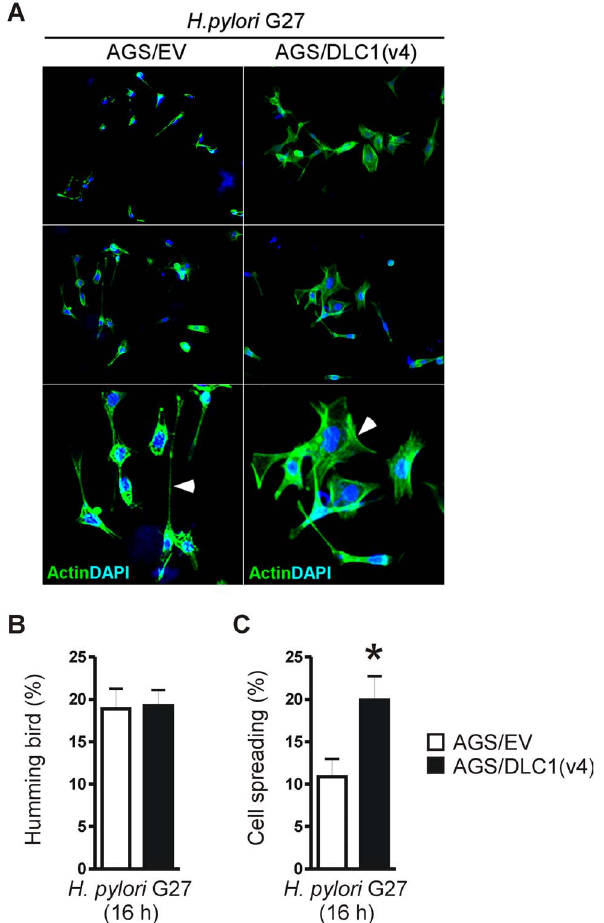
Figure 8. DLC1 rescues human GC cells from CagA-related adhesion defects. (A) AGS/EV cells were transiently transfected with pT-DLC1v4 plasmid for 24 h, followed by infection with CagA-delivery competent H. pylori G27 for additional 16 h and staining for immunofluorescence microscopy; green=actin (phalloidin), blue=- nuclei. Magnification 6 630. (B–C) Representative immunofluorescence images (A) are presented together with quantitative analyses of ‘‘humming bird’’ (B) and cell spreading (C) morphologies. Cell phenotypes were counted for at least 10 cells per field (total of 10 fields) and calculated as % 6 S.E. (n=3 experiments) of total cells; p=0.0067 AGS/EV versus AGS/DLC1.